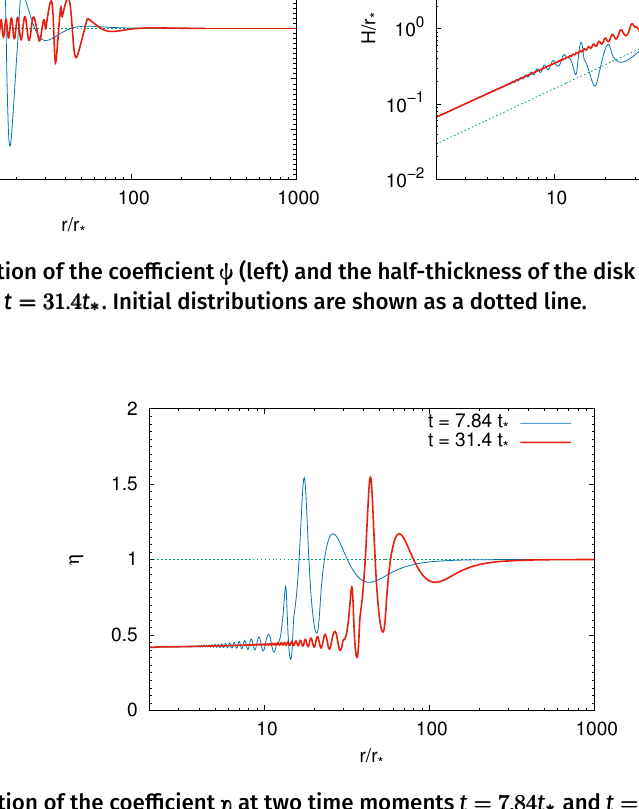
Figure 4. Radial distribution of the coefficient ηηη at two time moments t = 7 . 84 t ∗ t = 7 . 84 t ∗ t = 7 . 84 t ∗ and t = 31 . 4 t ∗ t = 31 . 4 t ∗ t = 31 . 4 t ∗ . The initial distribution is shown as a dotted